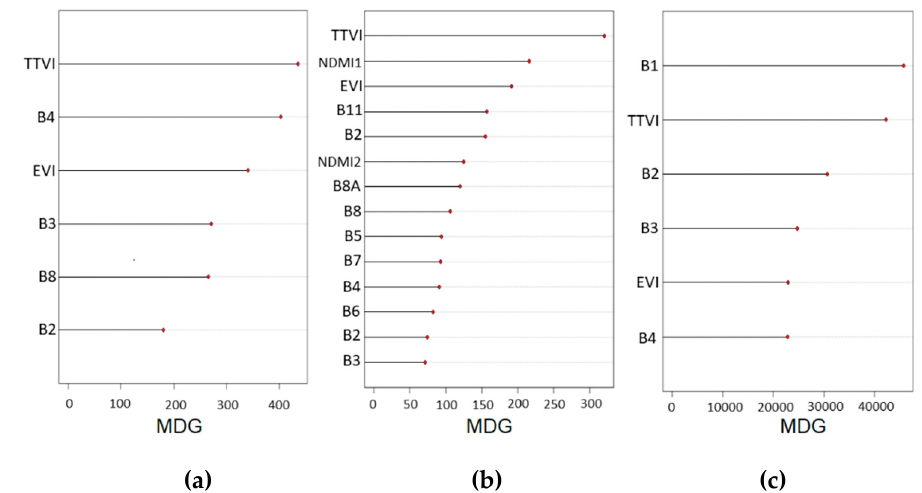
Figure 9. Importance of the variables according to Mean Decrease in Gini. Importance of Model 1 variables ( a ), Model 2 ( b ) and Model 3 ( c ). variables ( a ), Model 2 ( b ) and Model 3 ( c